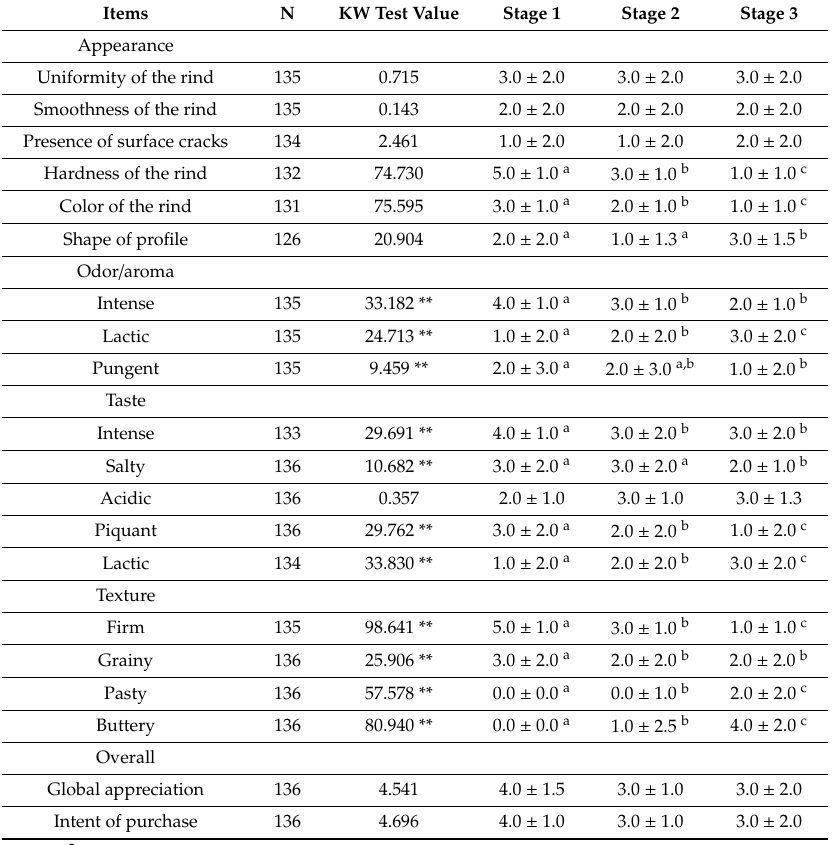
Table2. Descriptivestatistics(Median ± InterquantileRange),overallandbyripeningstage,anddifferences between ripening stages in sensory analysis